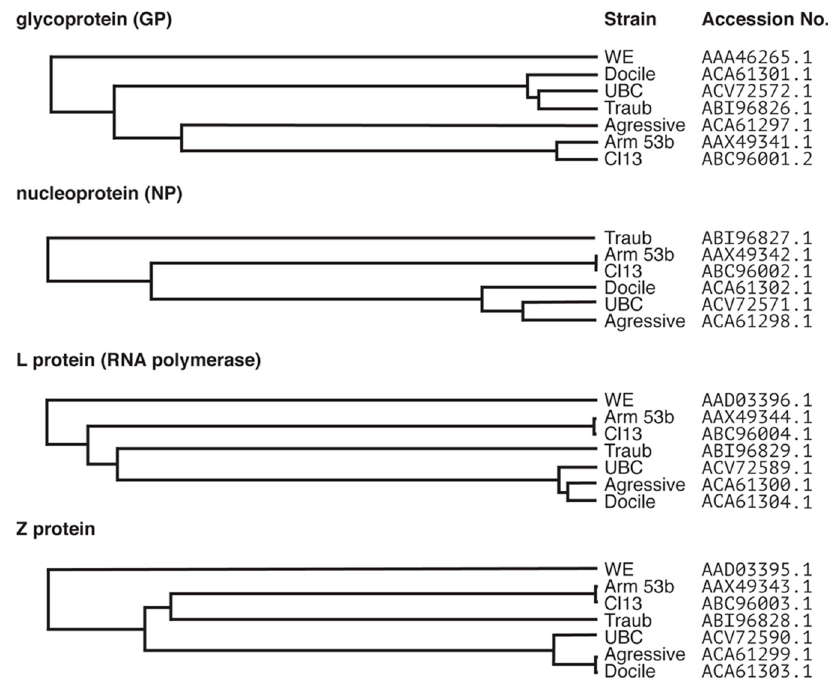
Figure 1. Clustal Omega dendrogram predications generated from the alignments of protein sequences of common laboratory strains of LCMV. The LCMV genome consists of the S and L segments. The S segment encodes the glycoprotein (GP) and the nucleoprotein (NP) and the L segment encodes the L protein (RNA polymerase) and the Z protein. Protein sequences for commonly used laboratory strains LCMV-Armstrong 53b, Clone13, Traub, UBC, WE, Aggressive and Docile were aligned using Clustal Omega and dendrograms generated from the alignments. Sequences were obtained from Genbank ® and accession numbers used for alignment are indicated. Note, there was no sequence available for the NP of LCMV-WE. The identity between the alignments is as follows; GP: 90.361%, NP: 94.086%, L protein: 81.315%, Z protein: 78.889%.